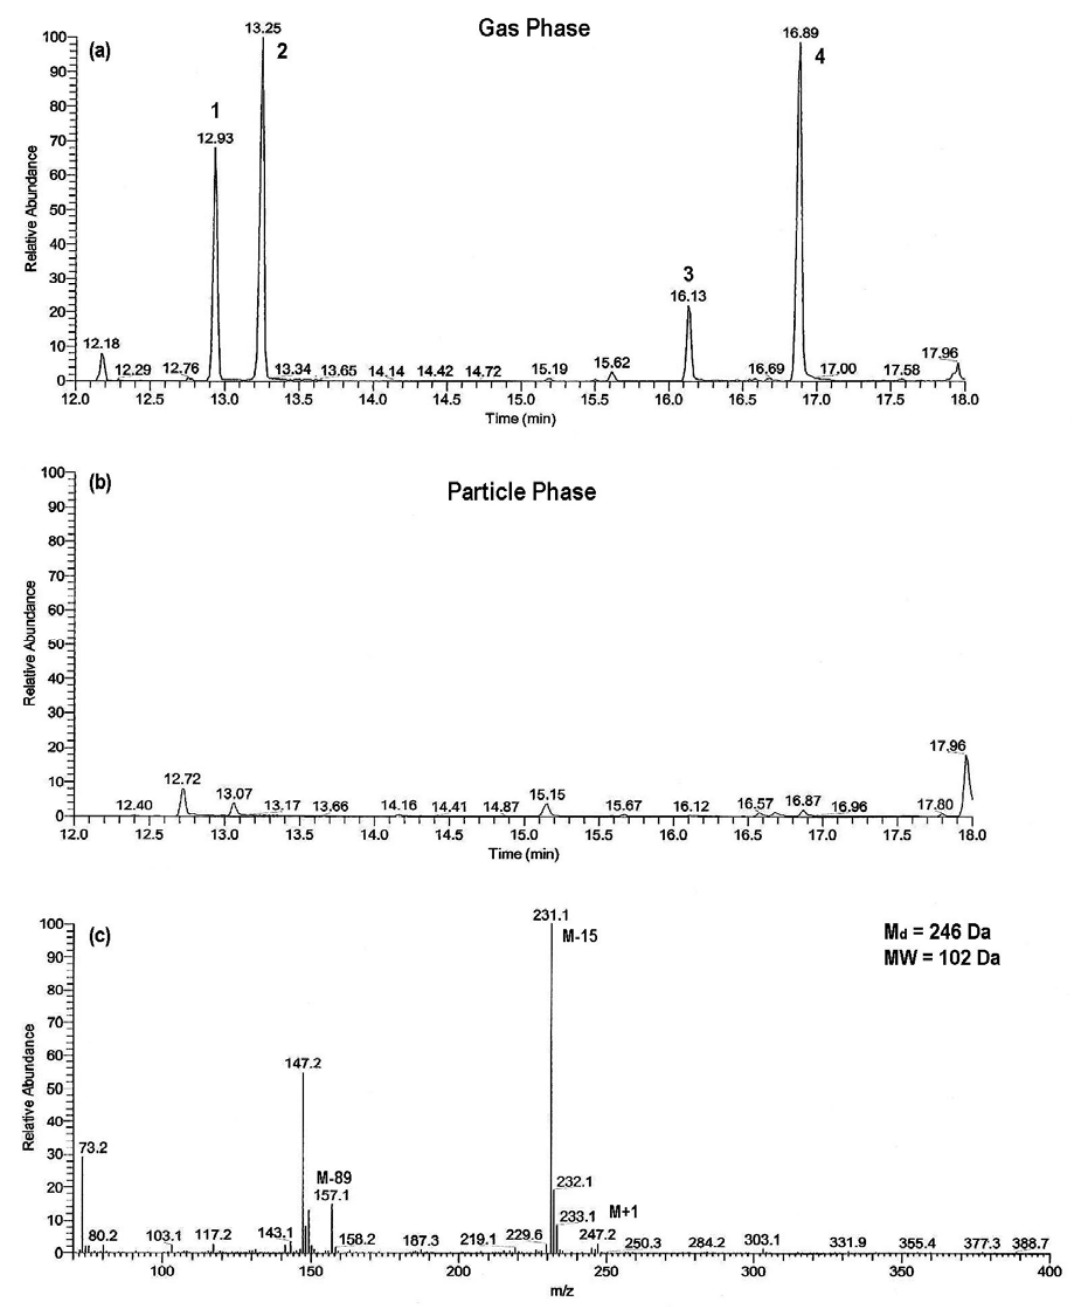
Fig. 2. Gas (a) and particle (b) phase chromatograms and mass spectrum (c) ; (Peak 1) of the butenediols in Experiment 2. For clarity in (a)